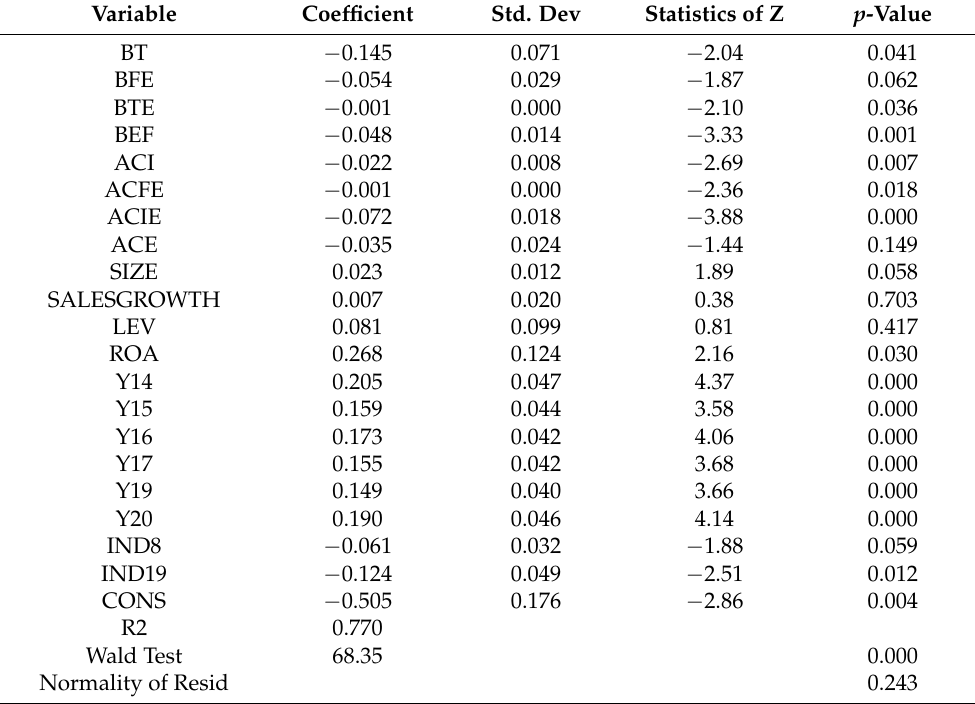
Table 11. The empirical findings pertaining first model considering the random